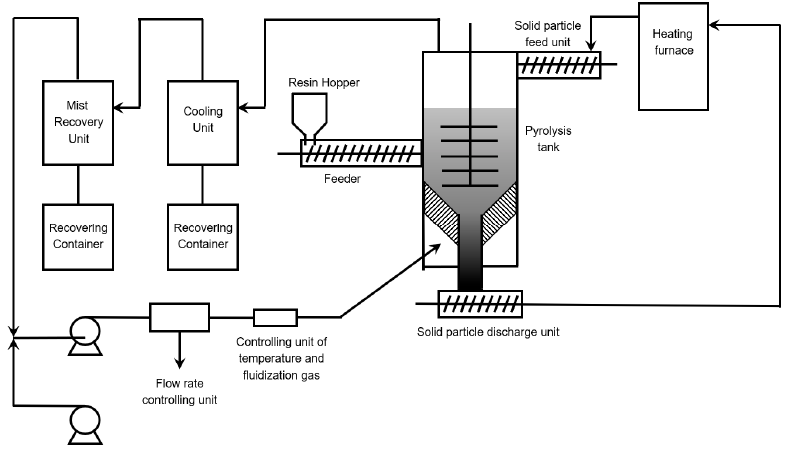
Figure 22. Alternative fluidized bed reactor technology as patented by Sasaki et al. [132] .